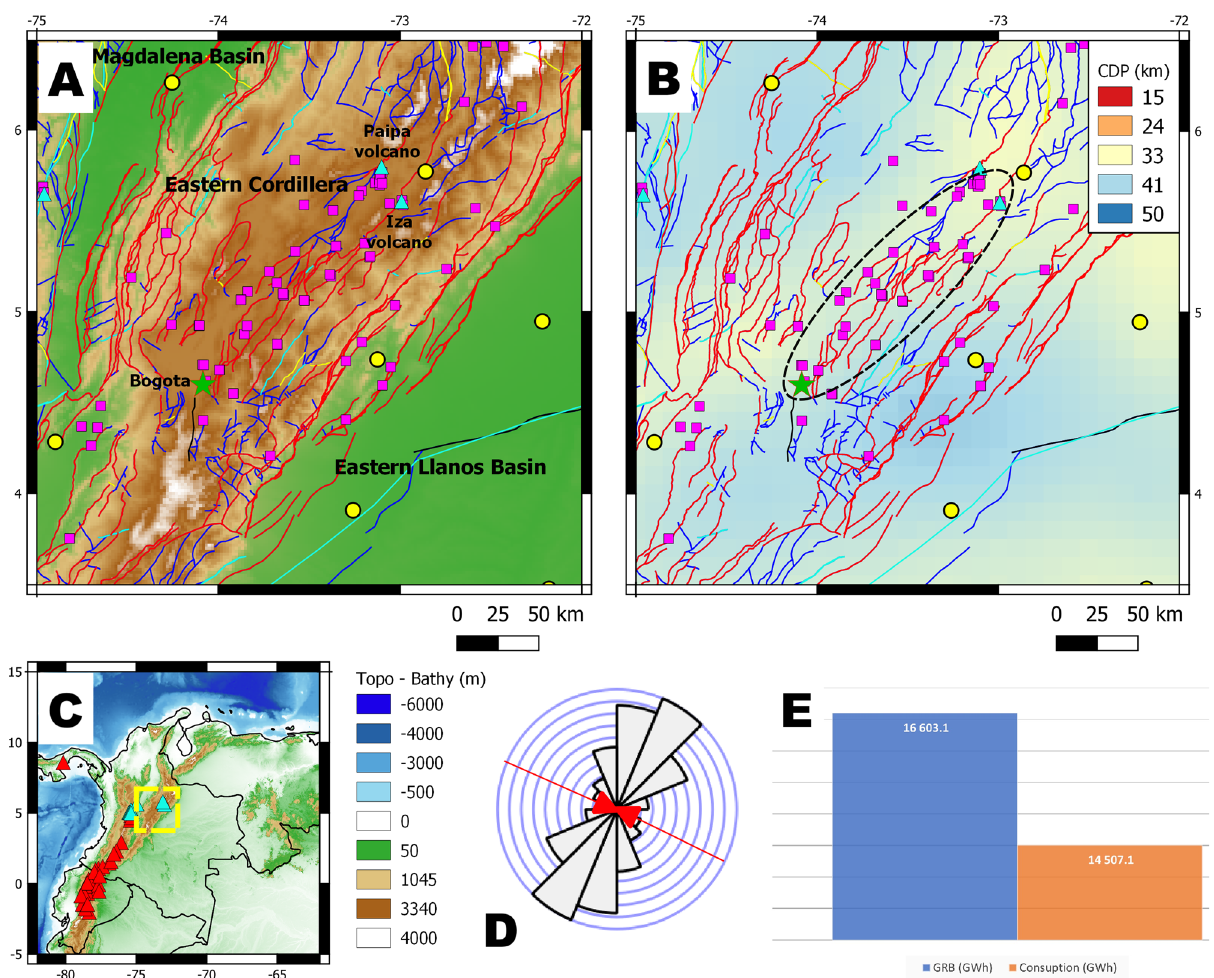
Fig. 2 Geothermal system north of Bogotá. A Spring water distribution (purple squares) in the north of Bogotá. B Calculation of the Curie Point Depth (CPD) in the area north of Bogotá 54 . Maps display normal faults (blue lines), reversal faults (red lines), right-lateral faults (cyan lines), left-lateral faults (yellow lines), active volcanoes (red triangles), inactive volcanoes (cyan triangles), and O&G fi elds (yellow dots). Topography from Amante and Eakins 59 . Black-dashed ellipse corresponds to the hypothetical envelope that encompasses the main geothermal lead. C Study area in a regional context; D rose diagram showing regional fault trending and the maximum principal stress direction (red arrows showing compressive regime); Rose diagrams are expressed in eight intervals of azimuth to the respective length of faulting. E Comparison between the potential geothermal power expressed as GRB (estimated in this work) and the current energy consumption in the metropolitan area of Bogotà. Coordinate system in